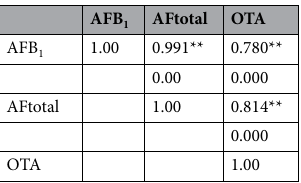
Table 12. Associations of mycotoxins (AFB 1 , AFtotal and OTA) in maize from Central Region. **Correlation is significant at the 0.01 level (2-tailed).